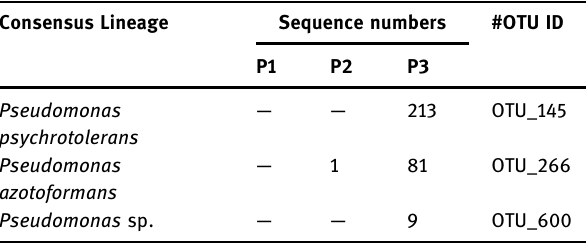
Table 2: Bacterial species identi fi ed from rearing water of com - mercial shrimp ponds on DOC